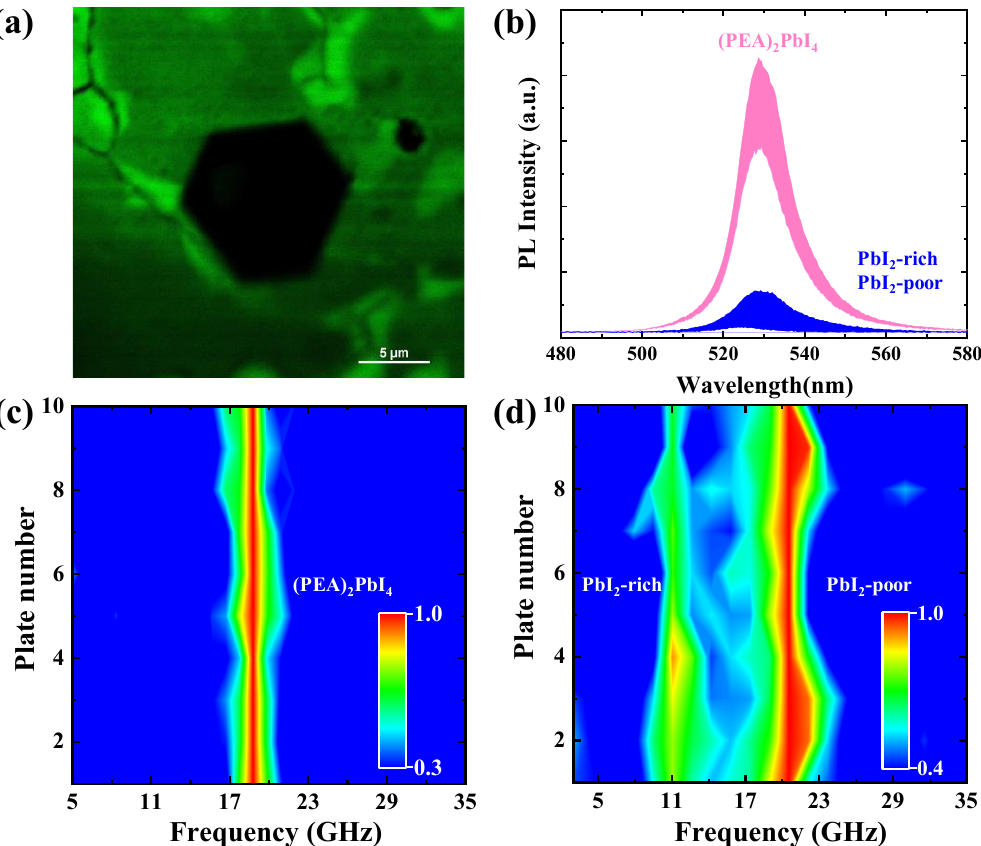
Figure 3: Correlation between Brillouin oscillations and PL intensities for the characterization of structural heterogeneity. (a) PL imaging of an area with a single Au NPL on top of (PEA) 2 PbI 4 fi lm. (b) Variations of PL intensity of (PEA) 2 PbI 4 fi lm at different locations where bright (PL intensity in top 20%) and dim (PL intensity in bottom 20%) areas were selected for Brillouin spectroscopy measurements. (c)and(d)arethecorrespondingFFTspectraofBrillouinoscillationsinareaswith brightanddimPL,respectively.The frequency at ∼ 19GHzin (c)correspondstopure(PEA) 2 PbI 4 wherePbI 4 octahedronispreserved.Thefrequenciesat ∼ 11and ∼ 21GHzin(d)areassignedtoPbI 2 -richand PbI 2 -poor phases,